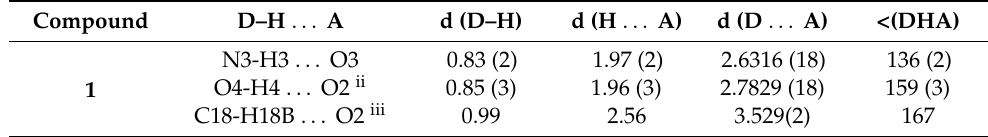
Figure 4. The crystal structure of the complex 1 . Displacement ellipsoids are drawn at 50% probability level. Table 3. The hydrogen bonding parameters for compound 1 Table 2. The selected bond lengths (Å ) and bond angles (°) for 1 .